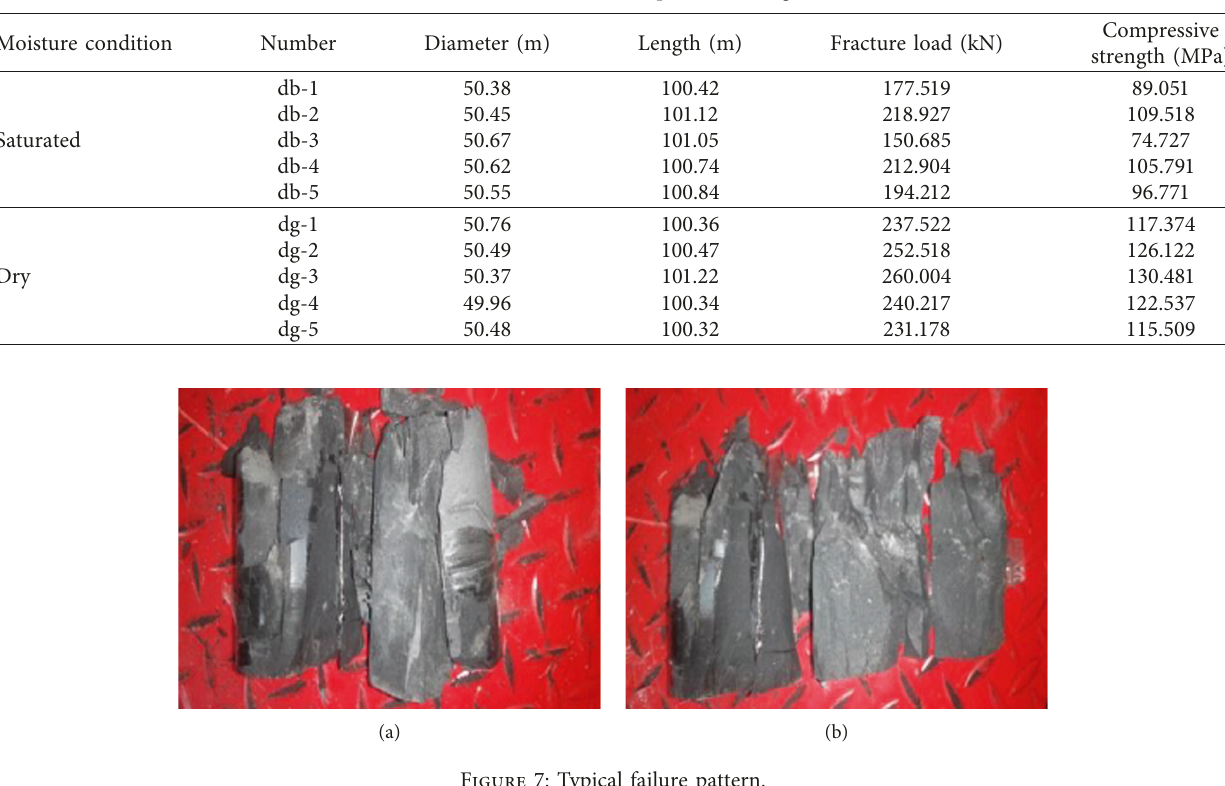
Figure 6: Fracture morphology of columnar jointed basalt under Table 2: The uniaxial compressive strength.